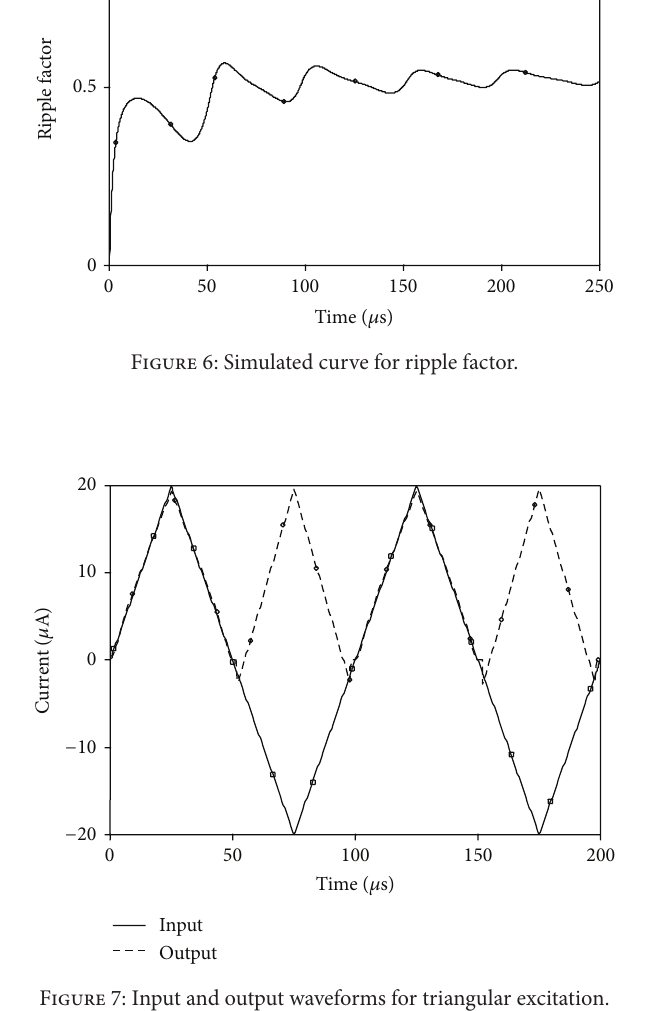
Figure 7: Input and output waveforms for triangular excitation.